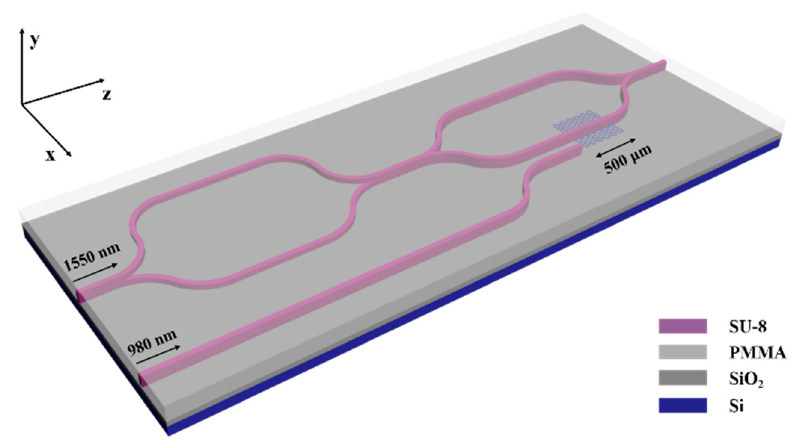
Figure 1. Schematic diagram of switch, including mode converter, pump light coupler, and first-order mode switch.